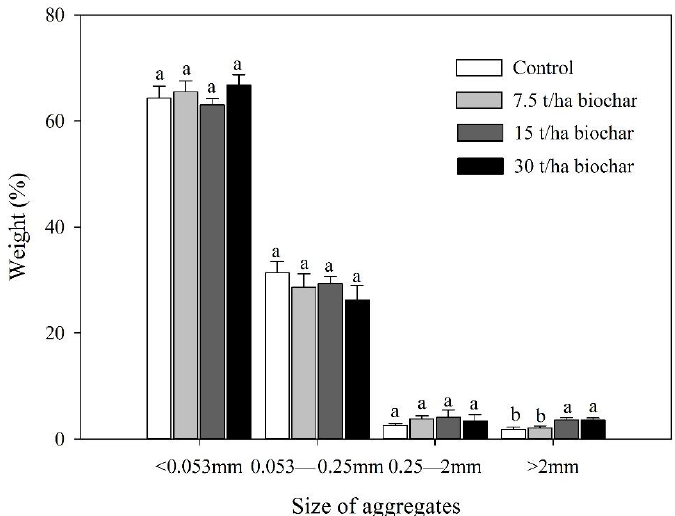
Figure 3. Changes in water stable aggregate percentages of soil as affected by biochar (BC) treat- ment. Error bars represent one standard deviation from the mean. Different letters indicate significant difference ( p < 0.05) between control and treatments in different years.